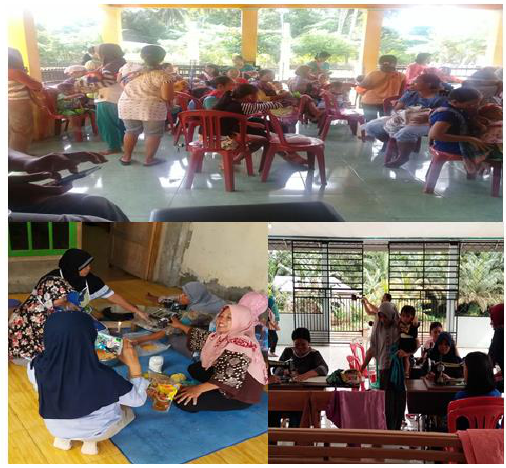
Source : Report on PD activities,